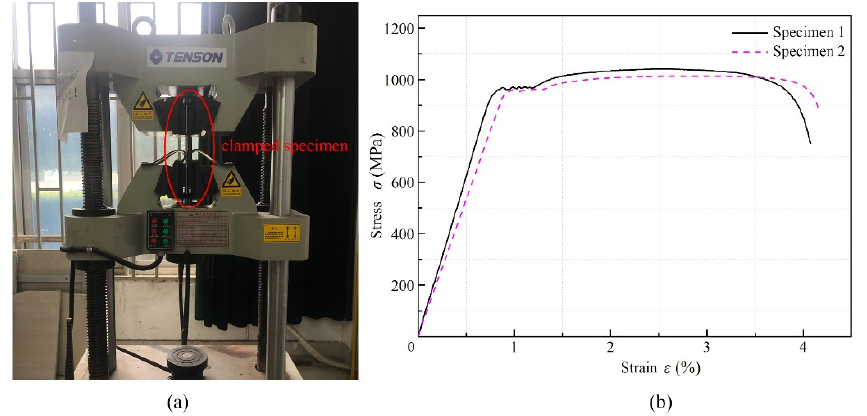
Figure 3. Tensile test of Ti-6Al-4V titanium alloy. ( a ) Equipment of tensile test; ( b ) The tensile curve of Ti-6Al-4V titanium alloy at room temperature.